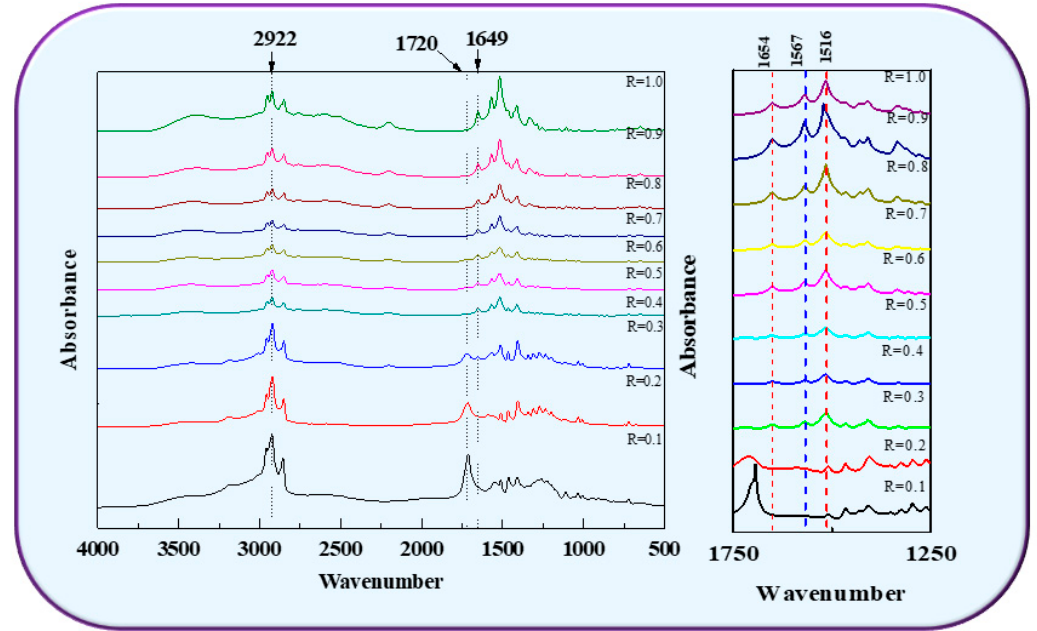
Figure 4. FT-IR spectra of FA/LA with different molar ratio vesicle sample.